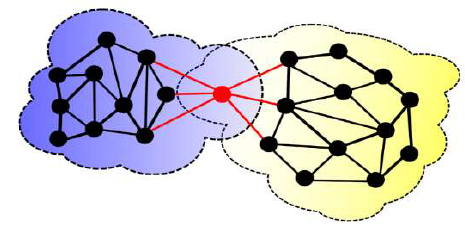
Figure 8. Example of bridging concept [8]